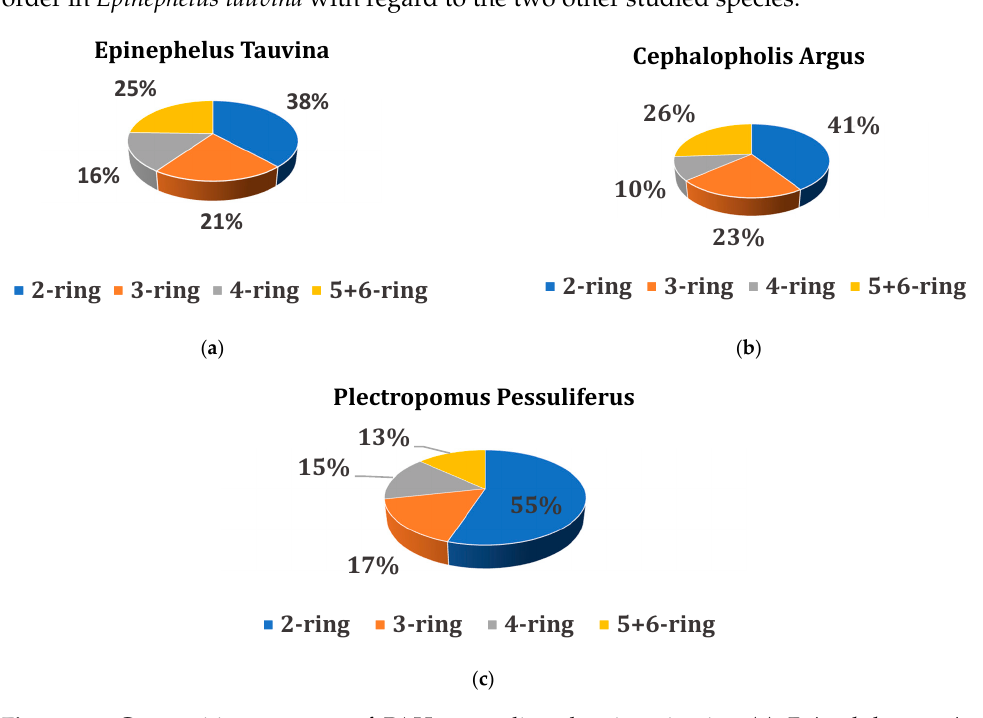
Figure 2. Composition patterns of PAHs regarding the ring size in: ( a ) Epinephelus tauvina ; ( b ) Cephalopholis argus ; and ( c ) Plectropomus pessuliferus .